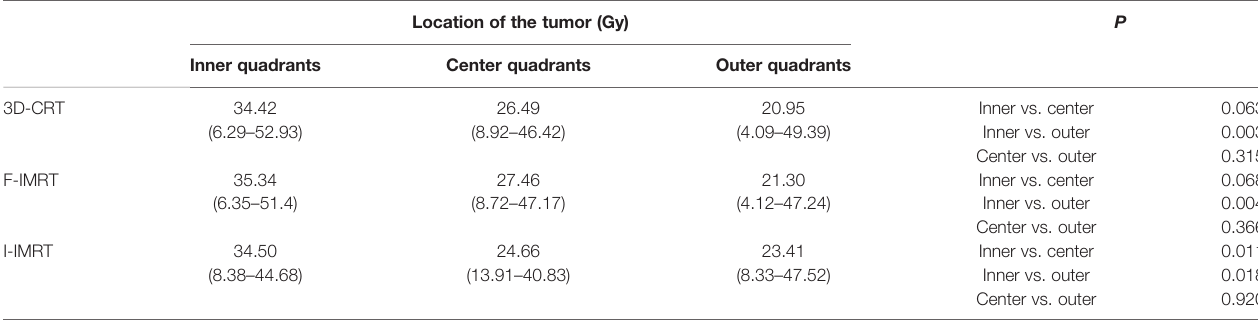
TABLE 4 | Impact of the location of the tumor bed on the incidental dose to the IMC. Location of the tumor (Gy)